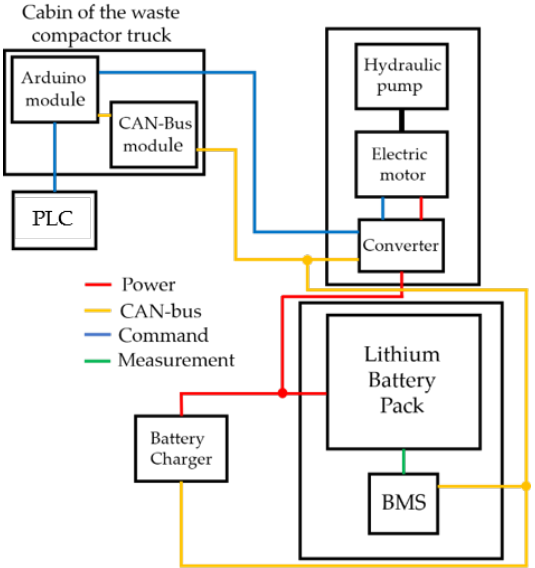
Figure 1. The overall block schematic of the electric-powered hydraulic pump system (e-HPS).